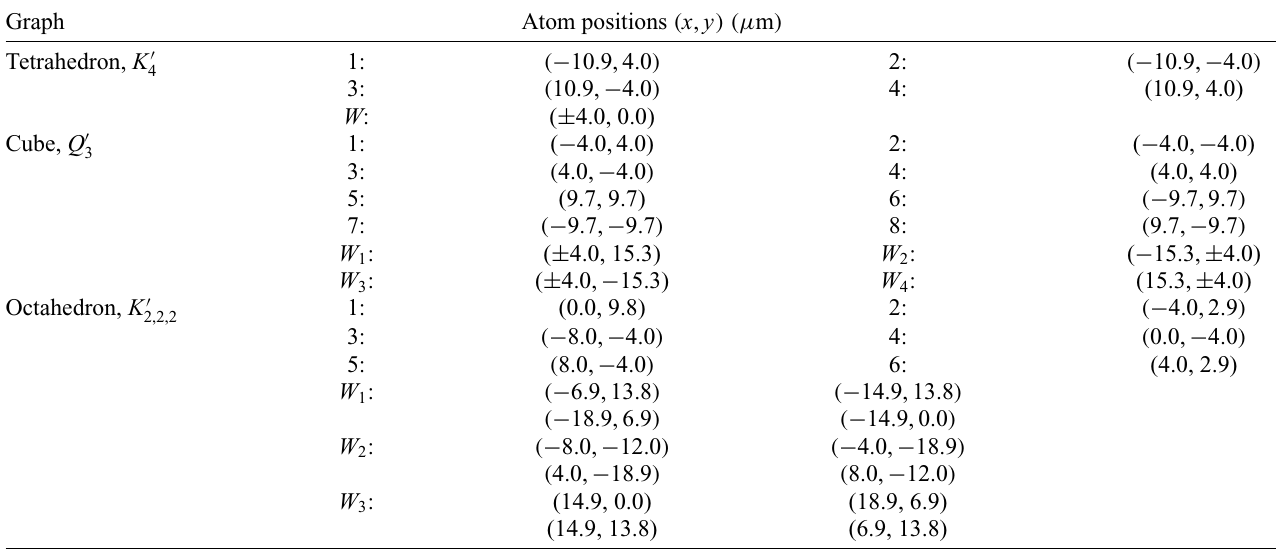
TABLE I. The atom positions for the experimental graphs.